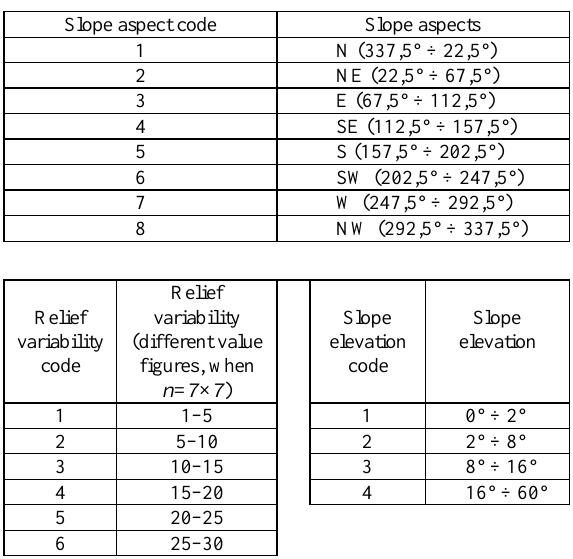
Table 2. Relief slope, aspect and variability classification